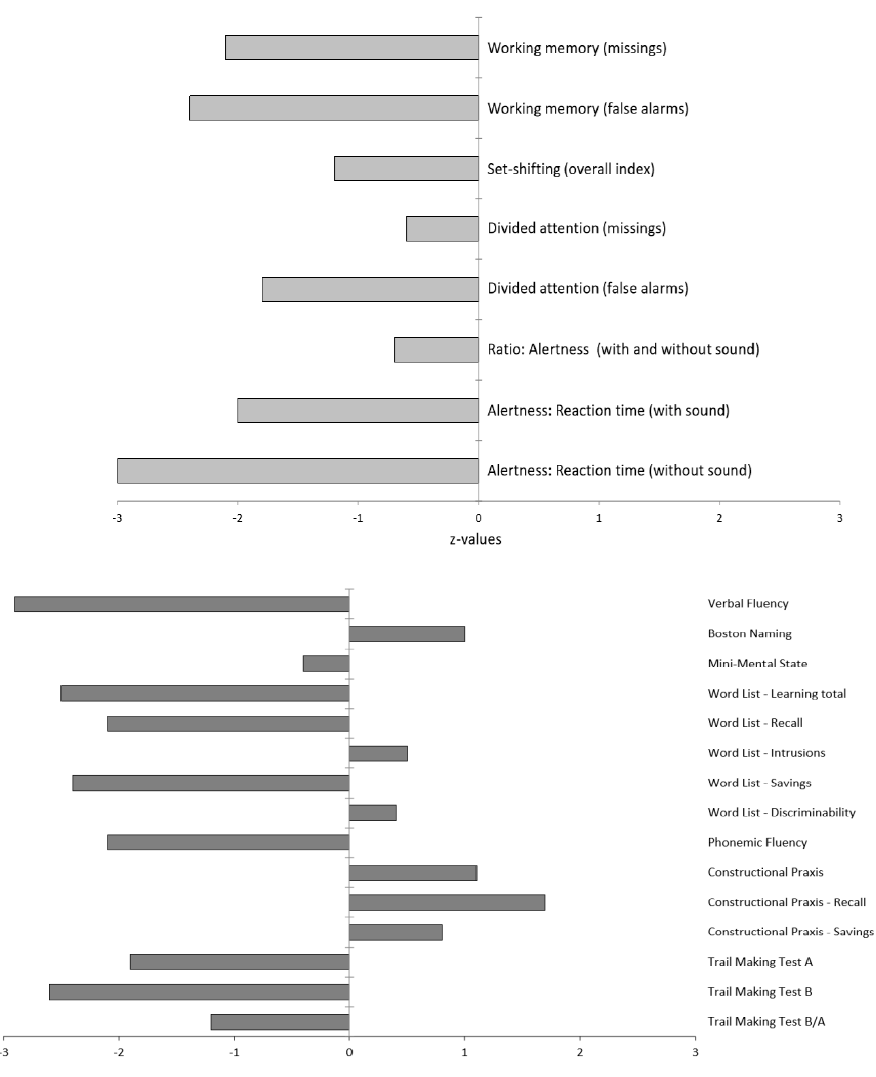
Figure 4. Neuropsychological test results. The testing of attentional performance (TAP) is shown above, and the “Consortium to Establish a Registry for Alzheimer’s Disease” (CERAD) test battery findings below. Z-values lower than 1 are below average, above 1 above average.